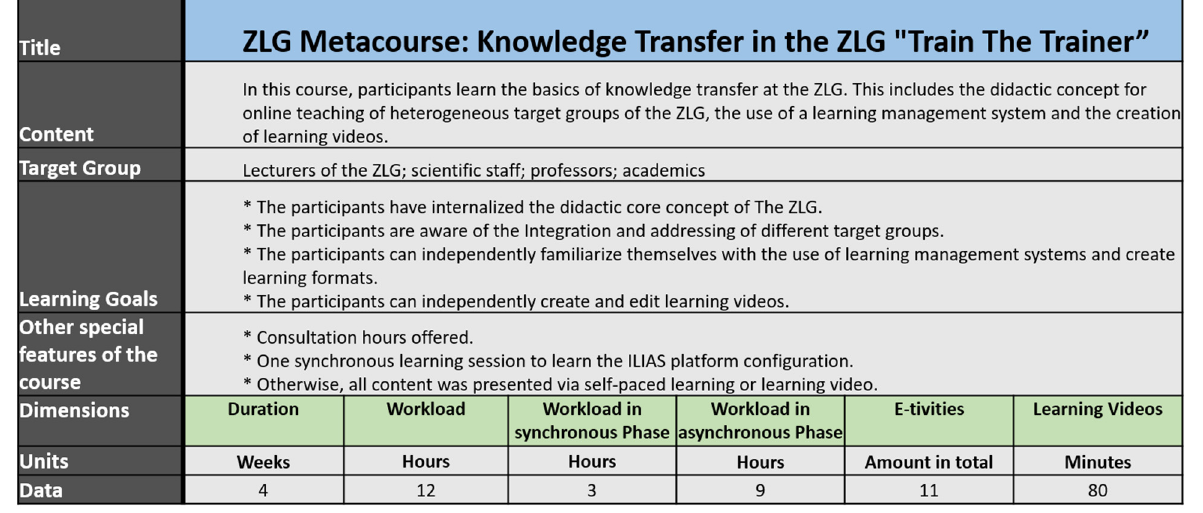
Figure 3. Course properties for ZLG-TP3 Metacourse: “Knowledge Transfer in the TLG “Train the Trainer”.